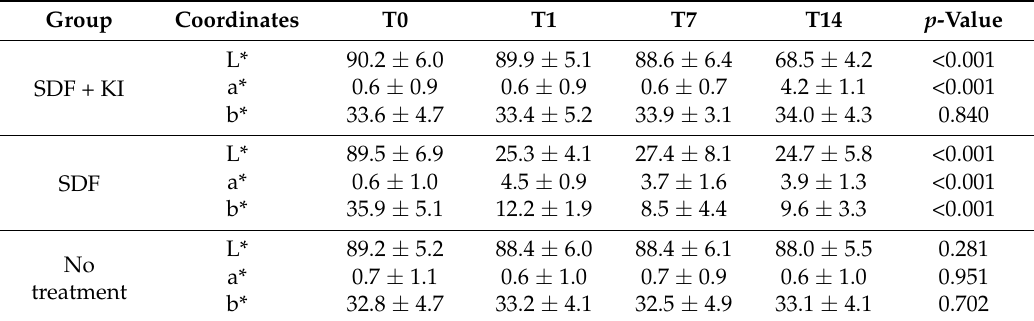
Table 1. Mean (±SD) values of L* a* b* coordinates of the three groups ( n = 10). Group Coordinates